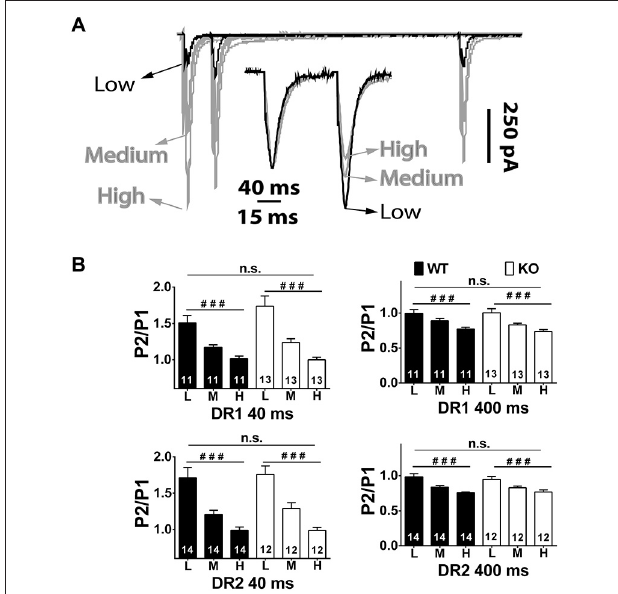
FIGURE 5 | Short-term plasticity in the direct and indirect pathway MSNs of NL1 KO mice at various divalent concentrations. (A) Main traces, similar conditions as in Figure 1 but at low (0.6 mM), medium (1.5 mM) and high (2.9 mM) [Ca 2 + ] e . To maintain total divalent concentration constant, Mg 2 + concentrations were (in mM); 2.4, 1.5 and 0.1, respectively. The peak amplitude of P1 as well as PP Depression (PPD) at IEI 400 ms showed a strong positive correlation to [Ca 2 + ] e . Instead, after normalizing traces at IEI 40 ms (inset), it is evident that PP Facilitation (PPF) showed an inverted relation to [Ca 2 + ] e , that is, the larger the [Ca 2 + ] e , the smaller the PPF. (B) As expected, repeated measures ANOVA showed a strong effect of [Ca 2 + ] e , on PPF and on PPD on both genotypes, but no significant changes in PPR between genotypes in either IEI and pathway were found. ### P <